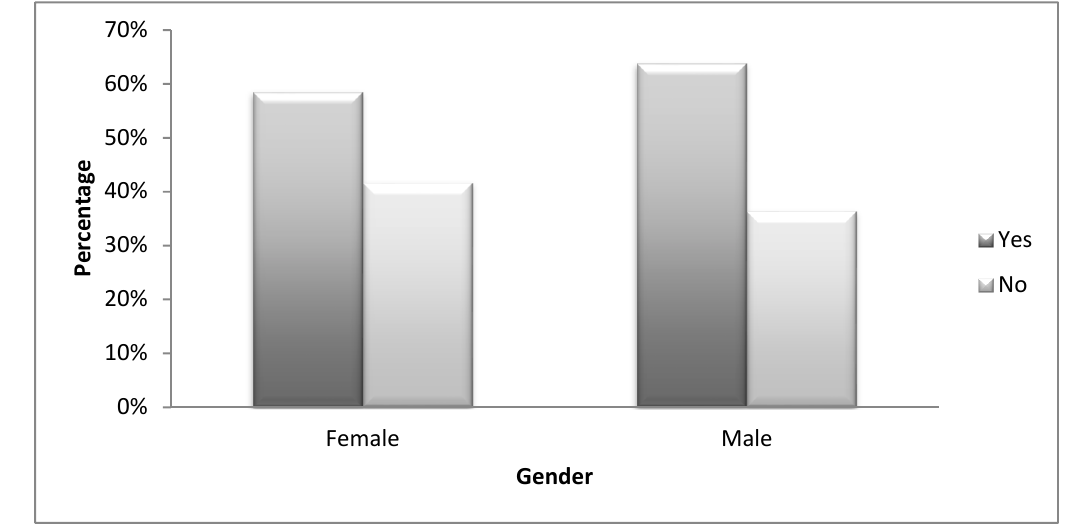
Figure 2. Use of alcohol within gender.